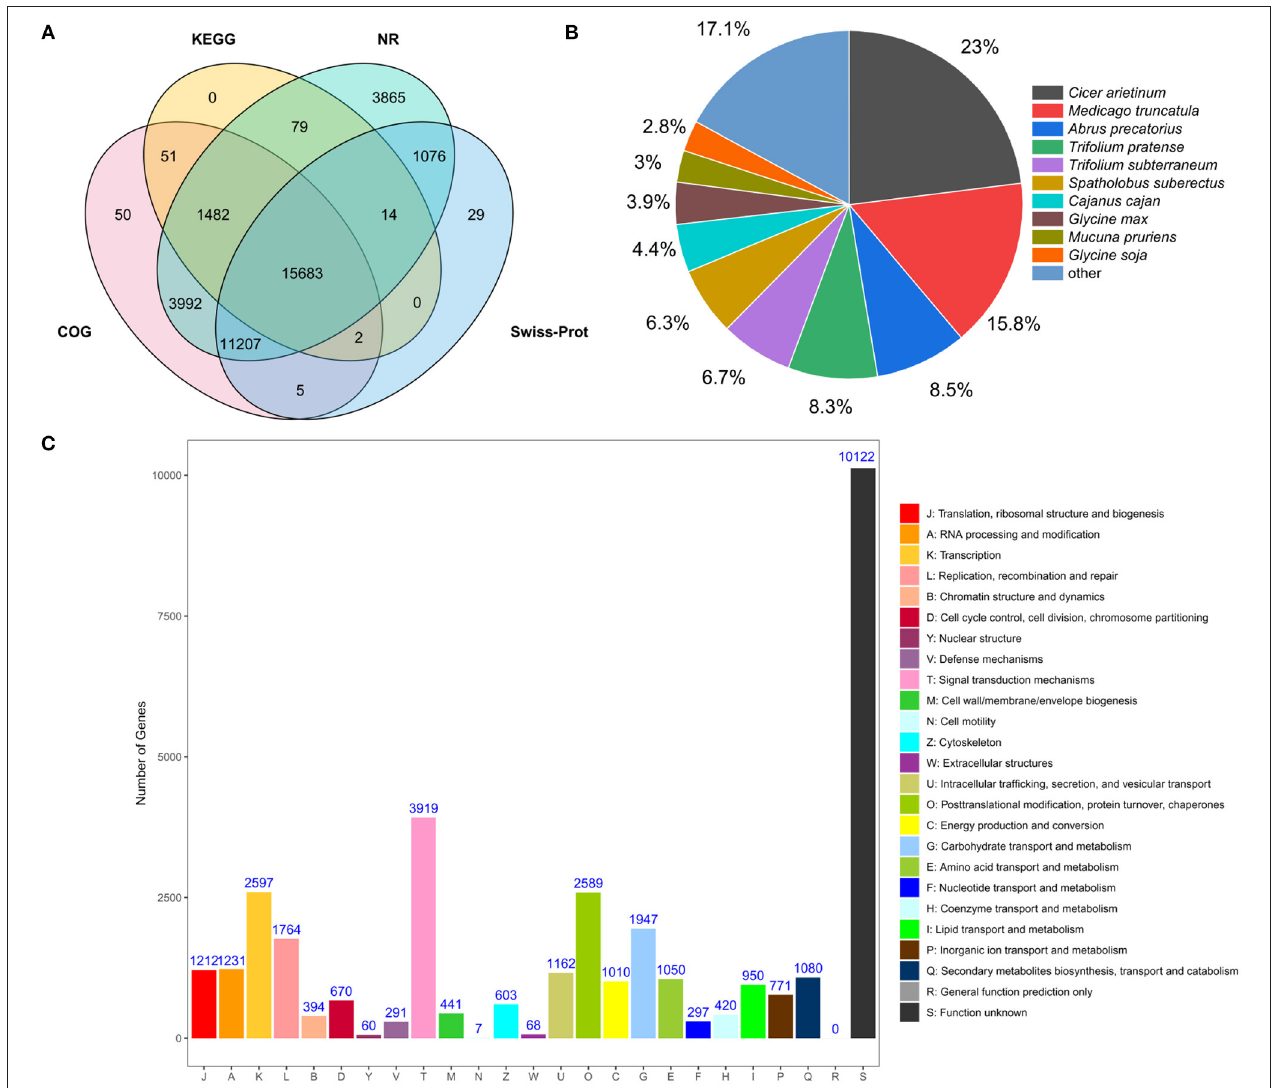
FIGURE 1 | Analyses of transcriptome data from leaves of sainfoin. (A) Venn diagram showing the number of unigenes co-annotated to KEGG, NR, COG, and Swiss-Prot database. (B) NR annotation shows the distribution of homologous species for unigenes of O. viciifolia . Compared to the NR database, the area of the sector represents the proportion of unigenes that are homologous to the corresponding species. (C) COG classification of unigenes of O. viciifolia . The horizontal axis represents 25 functional categories, and every category was displayed with different color bars, which are denoted by capital letters A ∼ Z. The vertical axis indicates the number of unigenes with corresponding functional categories. ( Supplementary Table 3 ), were used for multiple alignment with DNAMAN 9.0 software. For analyses of phylogenetic relationship, thirty-seven MYB proteins related to flavonoid synthesis from various plant species were aligned with DNAMAN software, and then, the phylogenetic tree was constructed by MEGA 11.0 software using the neighbor-joining (NJ) model with 1,000 bootstrap